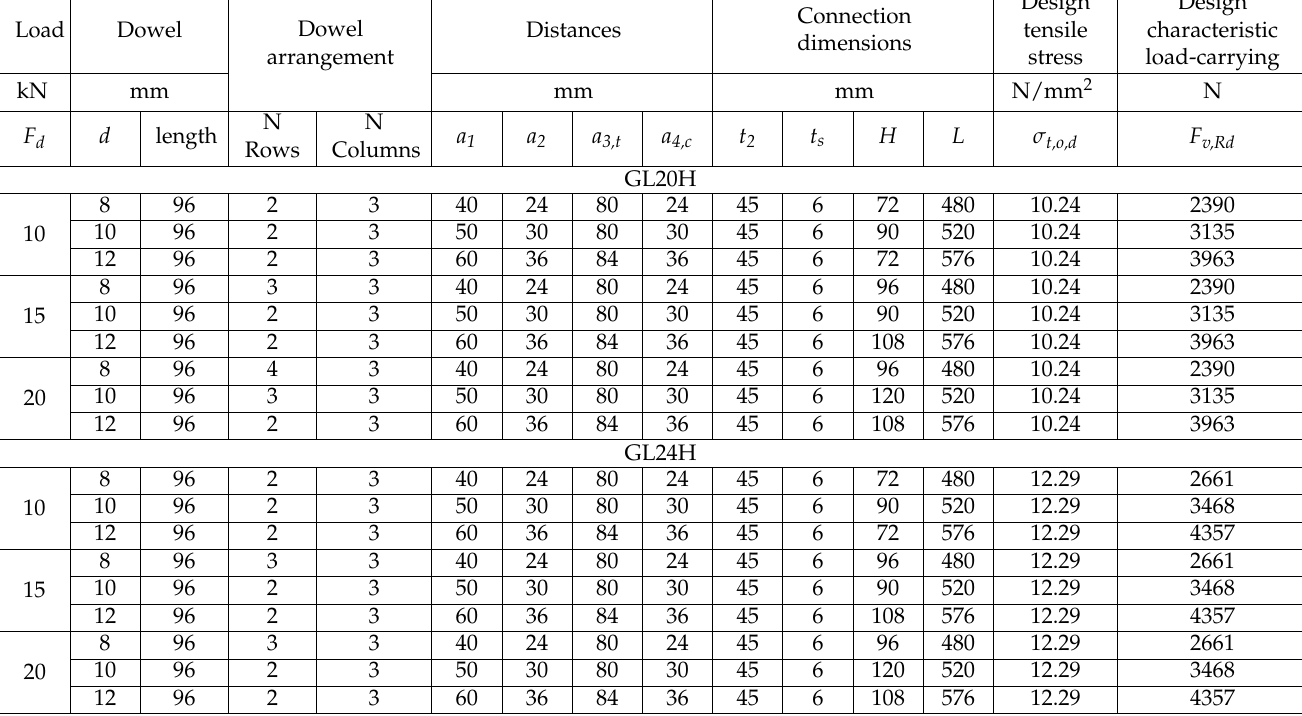
Table 2. Design parameters for W-S-W